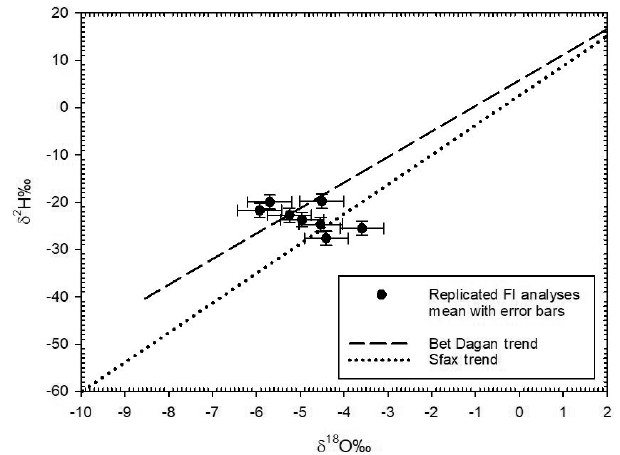
Figure 6. Double-replicated fluid inclusion measurements from SC-06-01 as well as regional precipitation isotope trends.